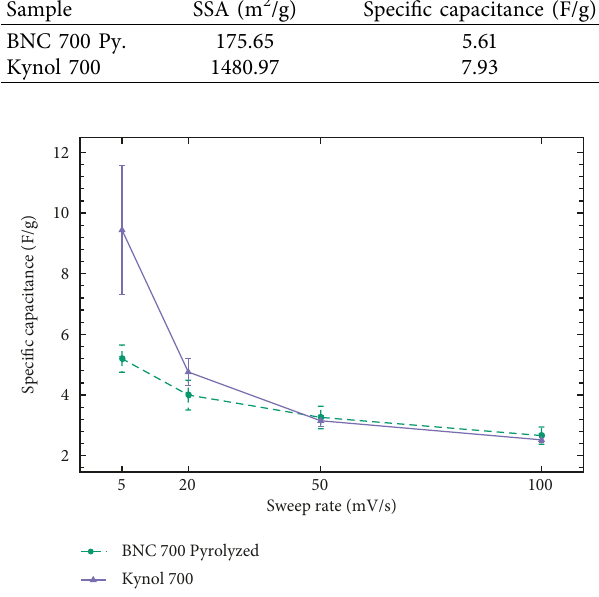
Figure 11: Specific capacitance versus sweep rate, from 5–100mV/ s. The error bars represent the standard deviation of measurements for two runs on each sample ( n �